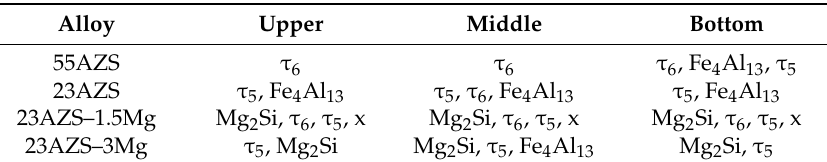
Table 3. The distribution of the dross phase.